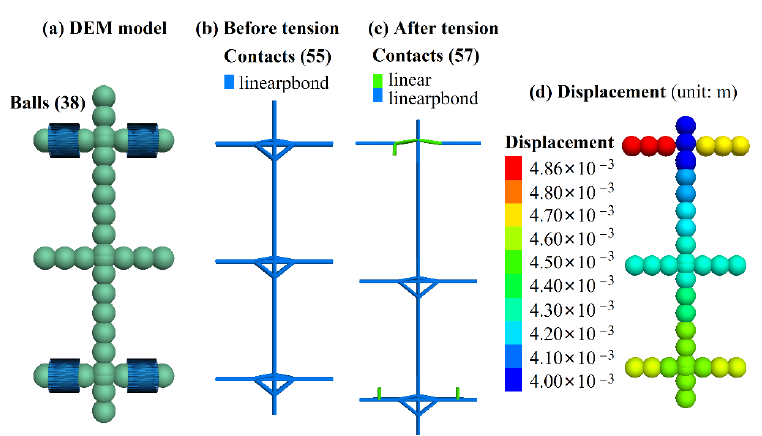
Figure 5. Single BFR simulated by PFC3D.